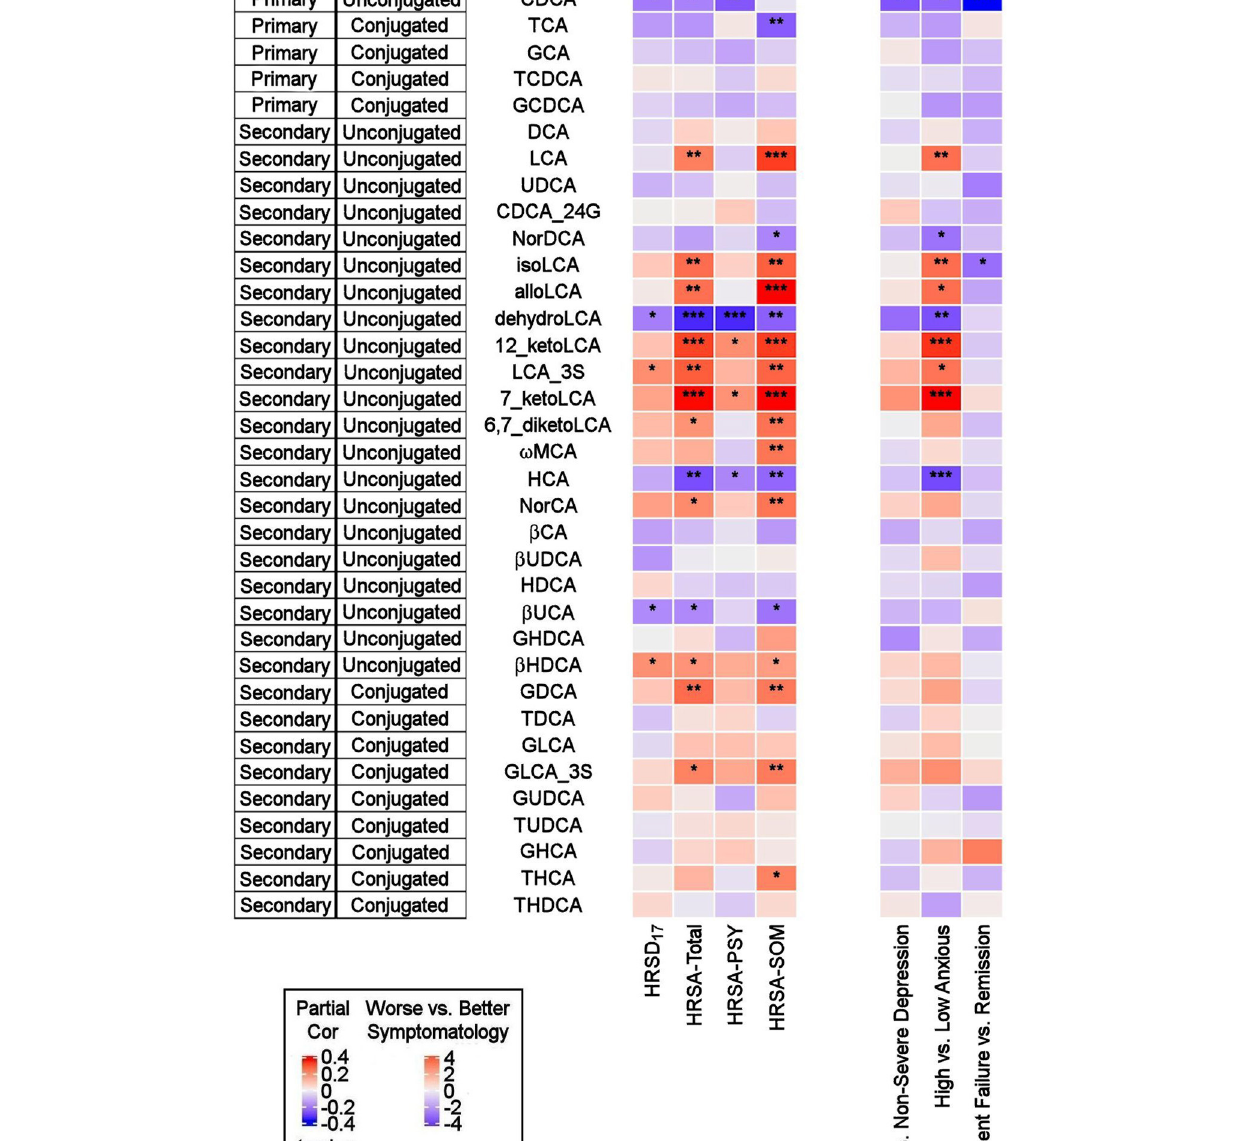
Frontiers in Neuroscience |